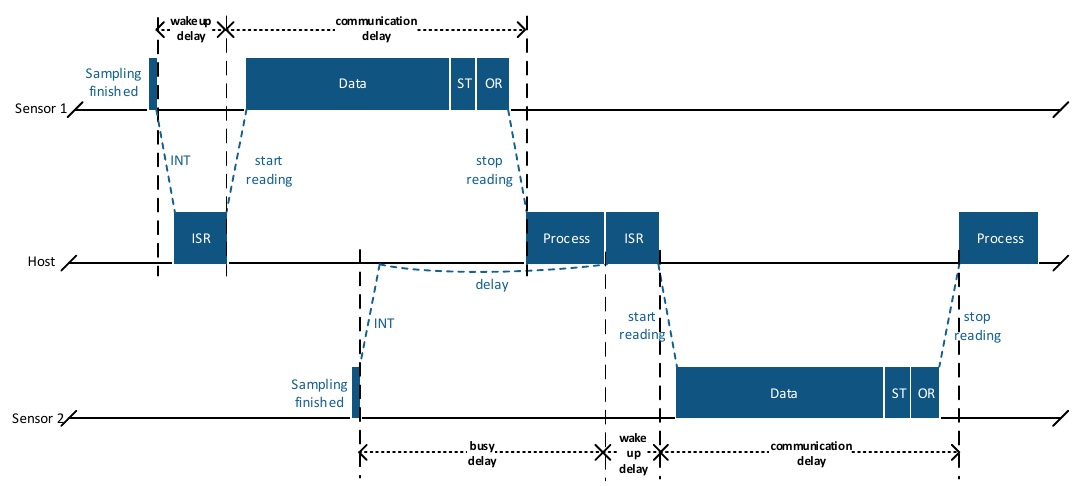
Figure 5. Exemplary communication between host and multiple sensor